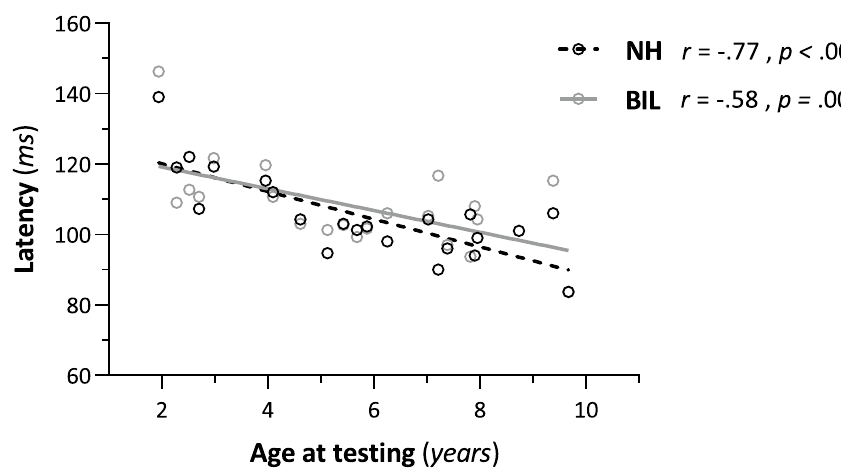
Figure 5. Correlations between P1 latency and age at testing in the NH (black dashed) and BIL (CI + NH) (grey solid) listening conditions. Individual data points represent mean latency for all three stimuli. Strong and moderate negative correlations were found for NH [ r (20) = − 0.77, p < 0.001] and BIL [ r (19) = − 0.58, p = 0.006] listening conditions,